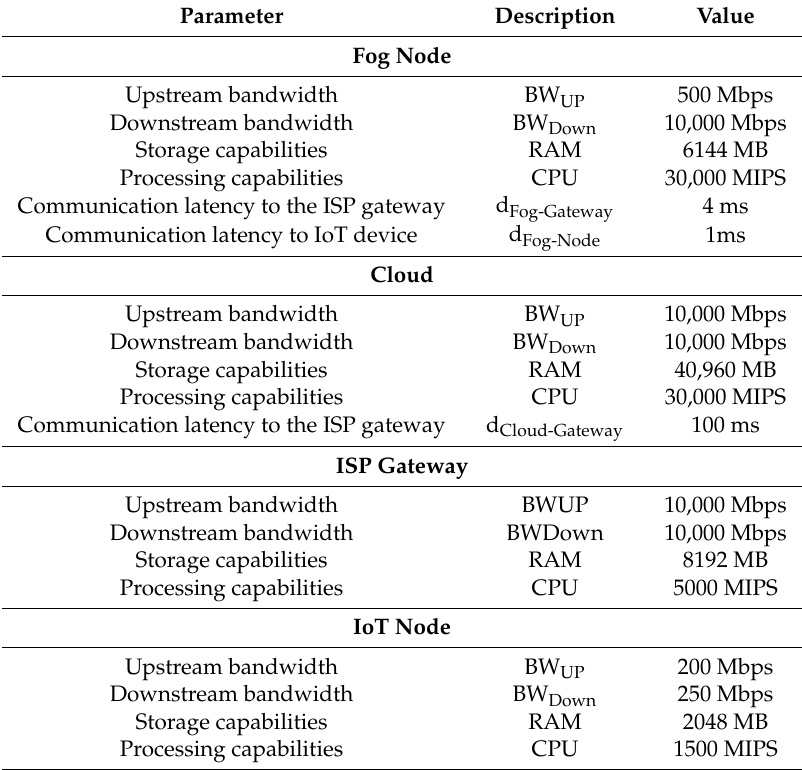
Table 2. The simulation parameters.